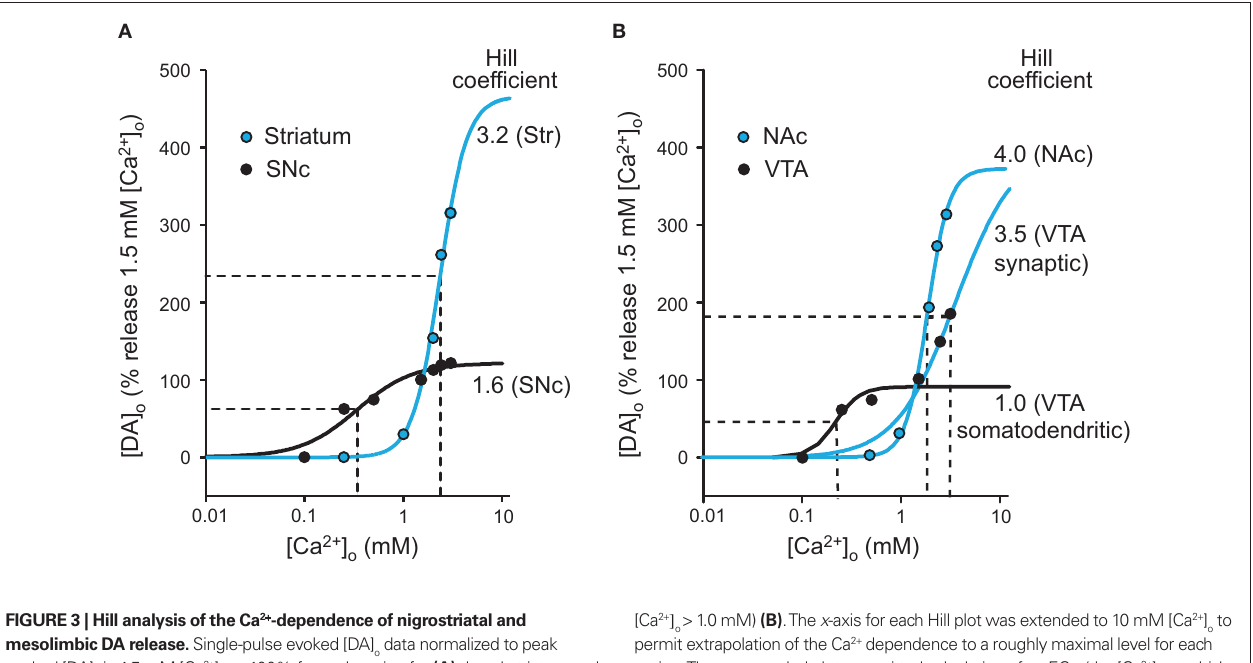
Figure 3 | Hill analysis of the Ca 2 + -dependence of nigrostriatal and mesolimbic DA release. Single-pulse evoked [DA] data normalized to peak o evoked [DA] in 1.5 mM [Ca 2 + ] as 100% for each region for (A) dorsal striatum and o o SNc and (B) NAc and VTA. Blue lines indicate Hill fit for axonal release, black lines for somatodendritic release. The Hill coefficient for each fit indicates the exponential dependence of DA release on [Ca 2 + ] . Both axonal and o somatodendritic were needed to fit data from the VTA ([Ca 2 + ] < 1.5 mM o